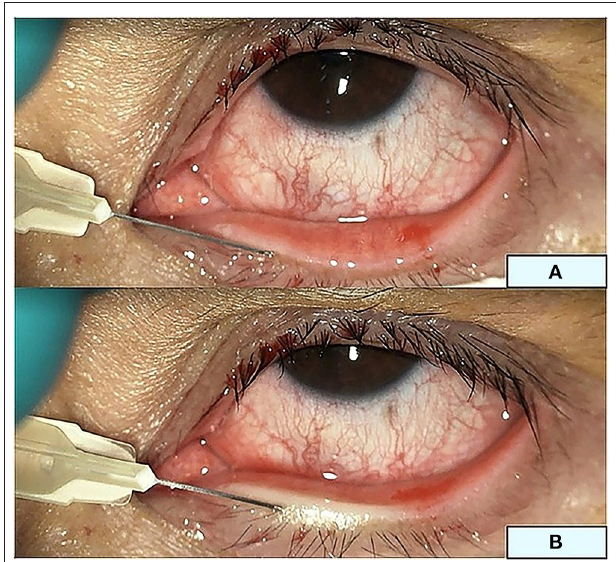
FIGURE 3 | Intra-meibomian gland injection. Three sites at the upper eyelid and two sites at the lower eyelid margin (A) for a total injection volume of 150 µ L. (B) The lower eyelid during